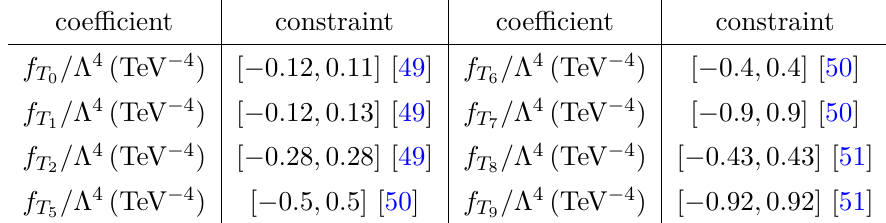
Table 1 . The existing LHC constraints on the O T